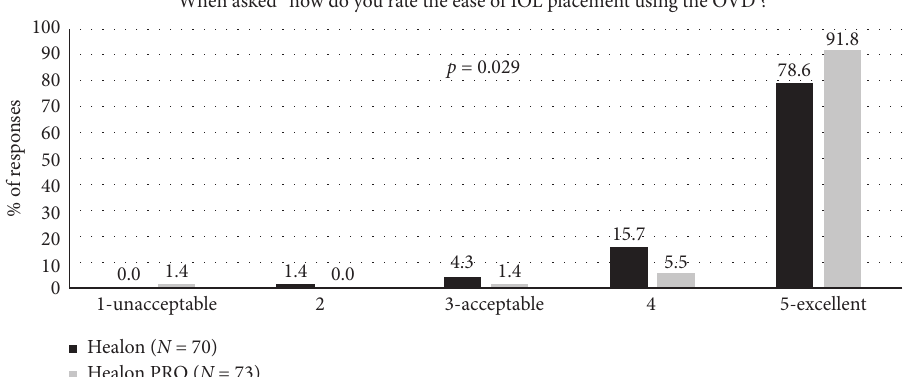
Figure 7: Ease of IOL placement during surgery for the Healon control and Healon PRO test groups, where “user acceptable” indicated a response of “3,” “4,” or “5.”